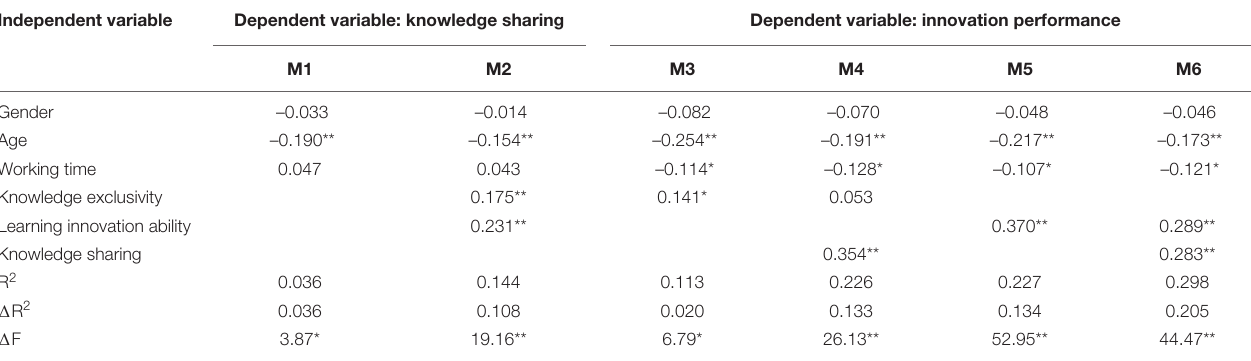
TABLE 5 | The mediating effect of member knowledge sharing on the impact of member ability on innovation performance. Independent